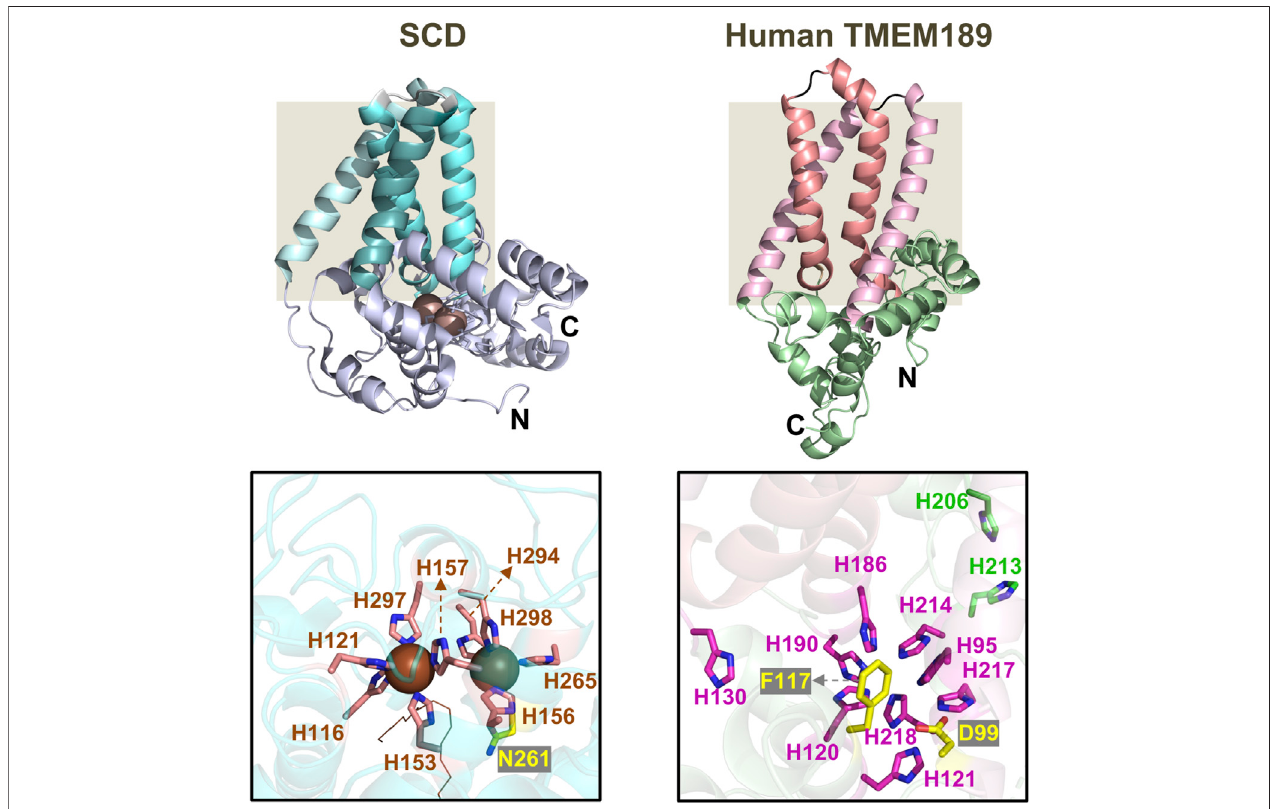
FIGURE 6 | The AlphaFold2 predicted structure of human TMEM189 compared to the crystal structure of SCD. Left: Crystal structure determined for mouse stearoyl-CoA desaturase/SCD (PDB accession code; 6WF2). Right:Single-chain AlphaFold2 structure ofhumanTMEM189(https://alphafold.ebi.ac.uk/entry/A5PLL7). The grey box highlights the transmembrane region with four helices in each structure. Shown below are close-ups of: (left) the diiron centre (dark spheres) and the nine coordinating His and one Asn (through a water molecule) in the SCD structure (a portion of the substrate in the active site is shown by thin lines); (right) the conserved His (magenta), Asp and Phe (both yellow) essential for function, and two conserved histidines (green) not required for activity in human TMEM189 (see